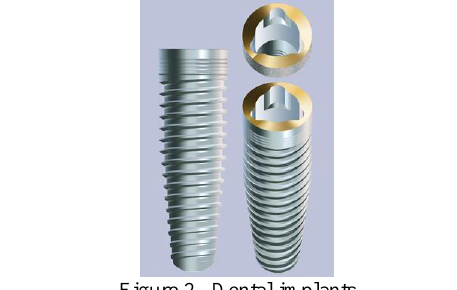
Figure 2. Dental